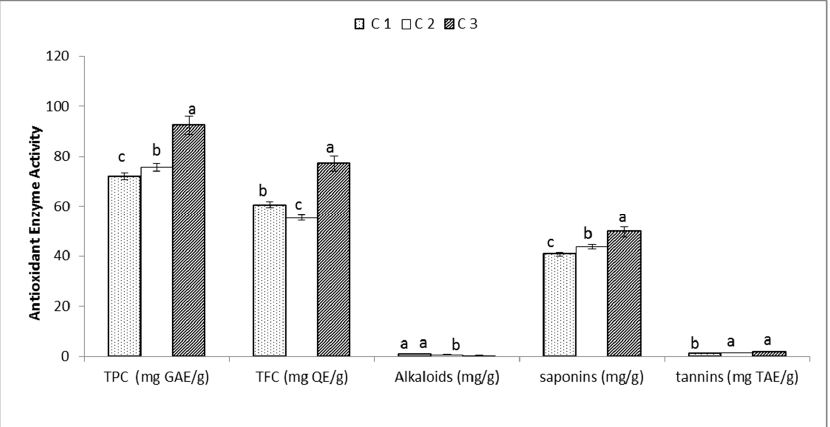
Figure 3. Phytochemical parameters for the studied C. gileadensis accessions (C1: collected from Jeddah, C2: collected from Jizan and C3: collected from Riyadh); TPC: total phenolic content; TFC: total flavonoids content. Bars with different letters indicate significant differences between treatments at p ≤ 0.05. Data are expressed as the mean of three replicates ± SDs.